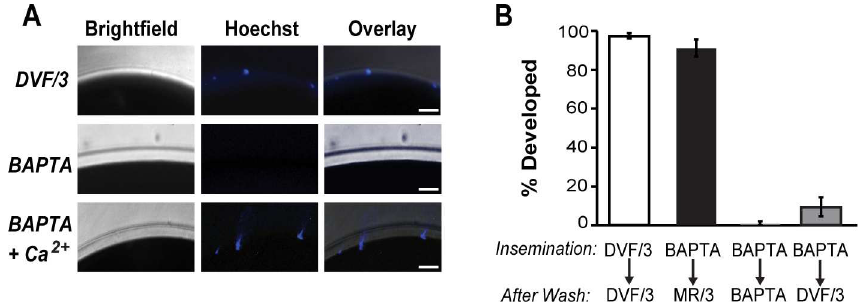
Fig 4. Sperm penetrate jelly but not the vitelline envelope of X . laevis eggs inseminated in BAPTA. (A) Inseminated eggs were incubatedin 0 or 3 mM BAPTA, and with 0 or 3 mM CaCl 2 , were stained with Hoechst to visualizethe sperm. 20 minutesfollowinginsemination, eggs were dejelliedand imagedusing fluorescence and bright-fieldmicroscopy to assess sperm penetration of the vitellineenvelope. Representative images documentthe presence of Hoechst-stained sperm within the vitellineenvelope of eggs inseminated in DVF/3 alone ( top ) or DVF/3 with 3 mM BAPTA and 3 mM CaCl 2 ( bottom ) (N = 33–56eggs in 4 experimental trials). By contrast, no Hoechst-stained sperm were evident within the vitellineenvelopeof eggs inseminated in DVF/ 3 with 3 mM BAPTA ( middle ).Scale bars represent 25 μ m. Red, dashedline on overlayindicates locationof envelope. (B) Incidenceof cleavagefurrow development of eggs inseminated in DVF/3 with 0 or 3 mM BAPTA, washedafter five minutes, and transferred to a final solution as indicated(N = 75–87 eggs in 3 experimental